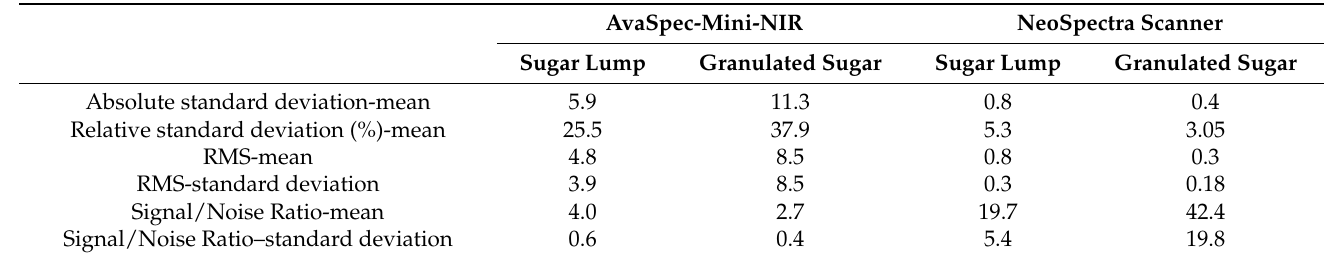
Figure 1. Spectra of sugar samples acquired with the miniaturized NIR spectrometers (90 acquisition with each instrument). ( a ) AvaSpec-Mini-NIR; ( b ) NeoSpectra Scanner. Table 1. Descriptive statistics of sugar spectra calculated on percentage reflectance.